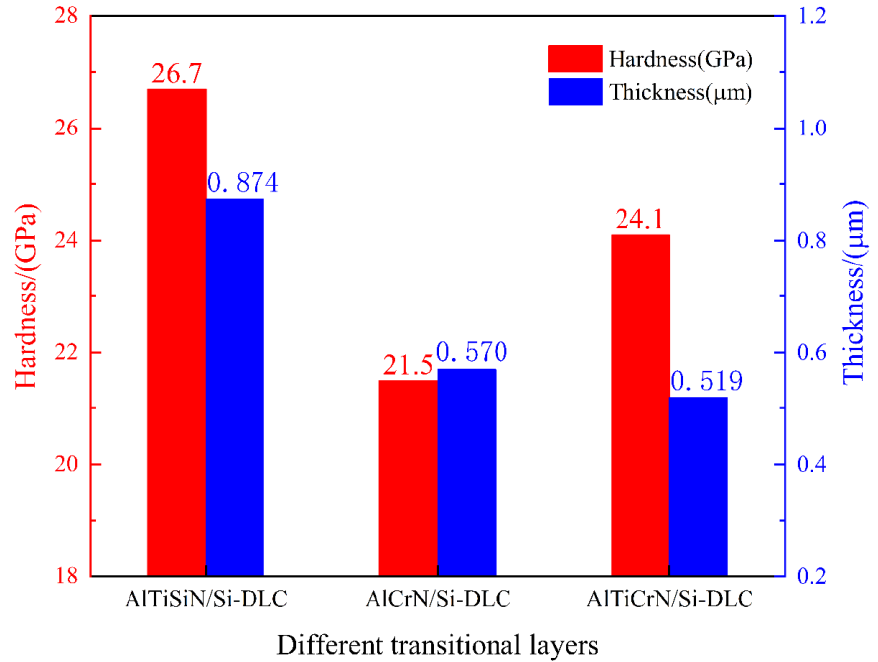
Figure 6. Hardness and film thickness values of Si-DLC with different transition layers.